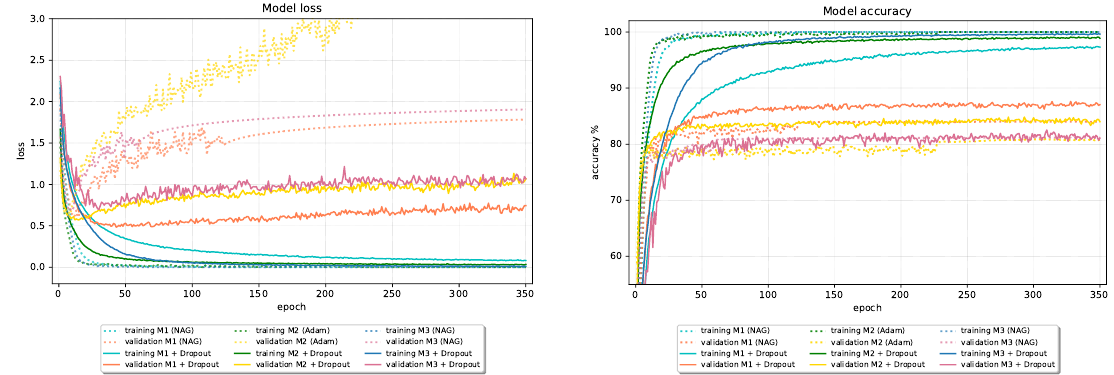
Figure 11. The effect of Dropout on baseline models trained on CIFAR-10